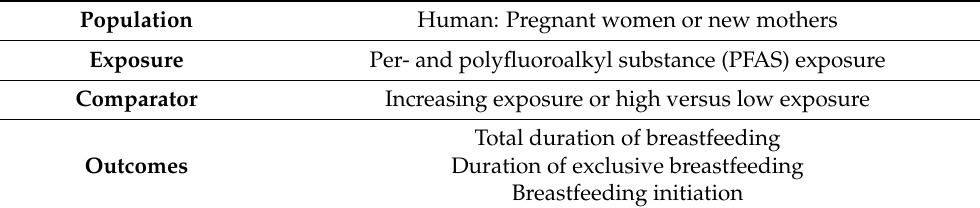
Table 2. PECO (population, exposure, comparator, and outcomes)